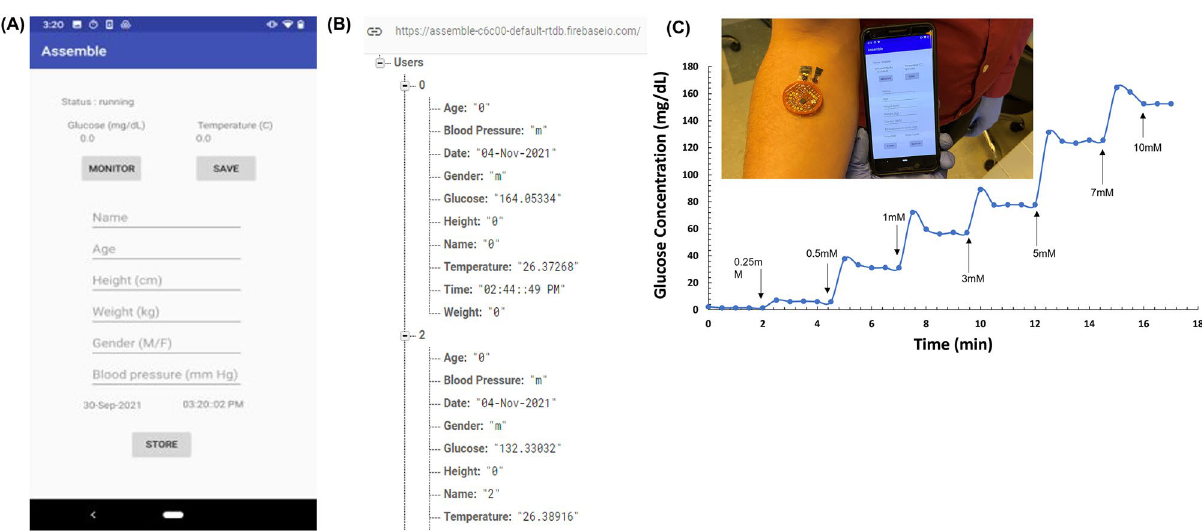
Figure 7. ( A ) Smartphone interface for glucose and other independent feature capture ( B ) Firebase Realtime cloud database. ( C ) Stability profile of glucose monitoring system operating on increasing concentration